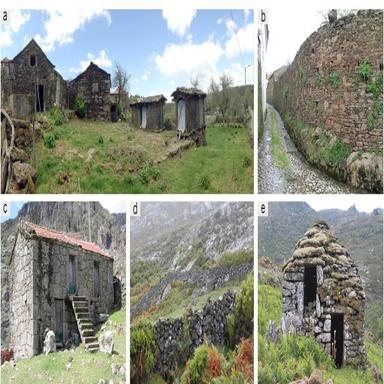
Examples of Northwest Portuguese vernacular dry stone heritage. Schist examples (above): (a) farmhouse; (b) farm walls. Granite examples (bellow): (c) mountain range rural house; (d) farm walls; (e) corbelled dome shelter.